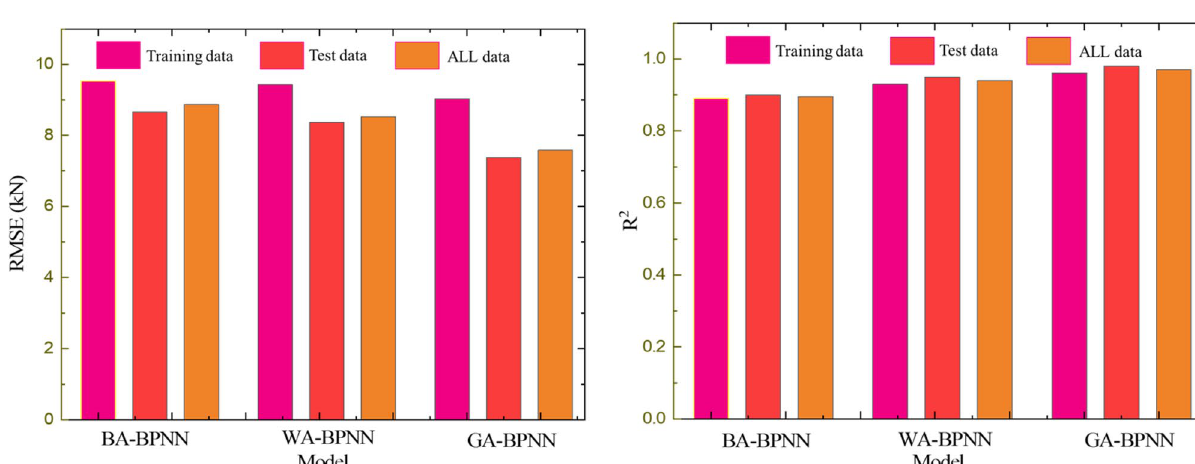
Figure 19. Comparison of GA-BPNN, BA-BPNN,